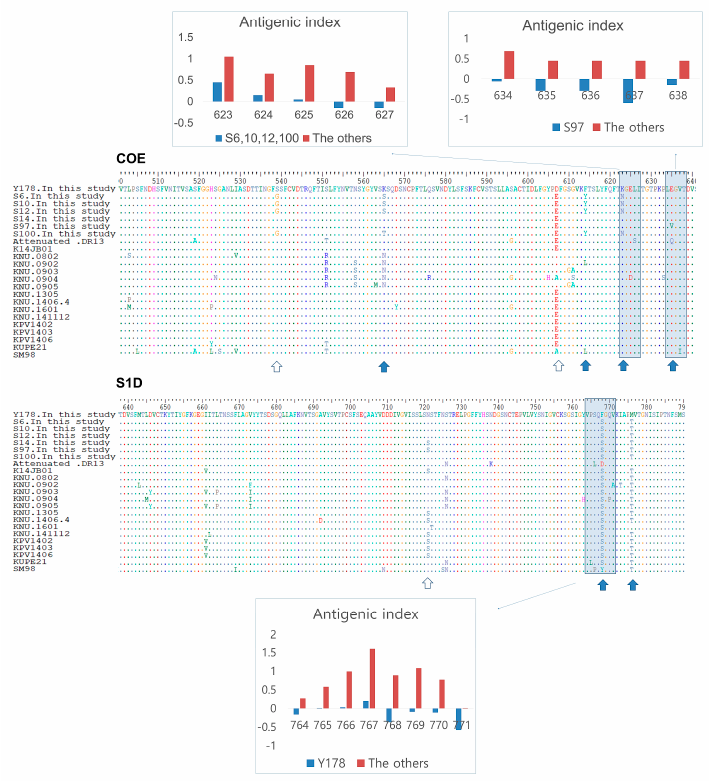
Figure 6. Antigenic index analysis of S protein B-cell epitopes in Korean PEDV strains. Strains S6, S10, S12, and S100 exhibited lower antigenic indexes, below the cut-off value of 0.5, at amino acids